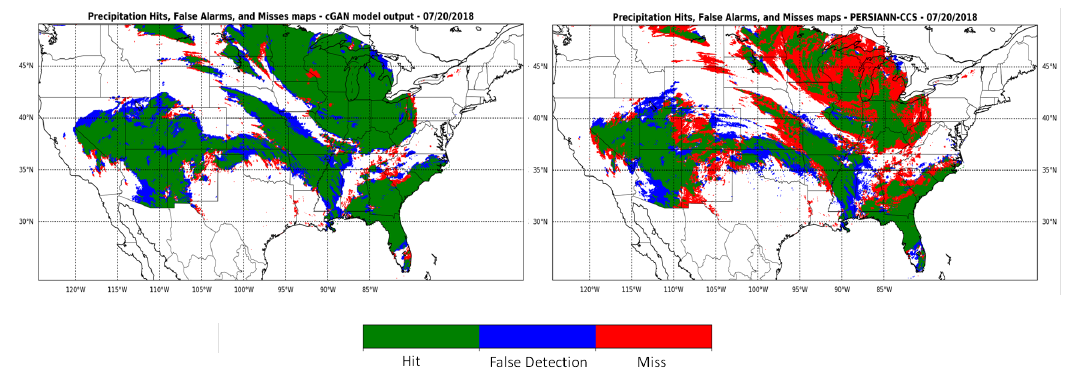
Figure 6. Visualization of precipitation identification performance of PERSIANN-CCS vs cGAN model output over the United States for 20 July